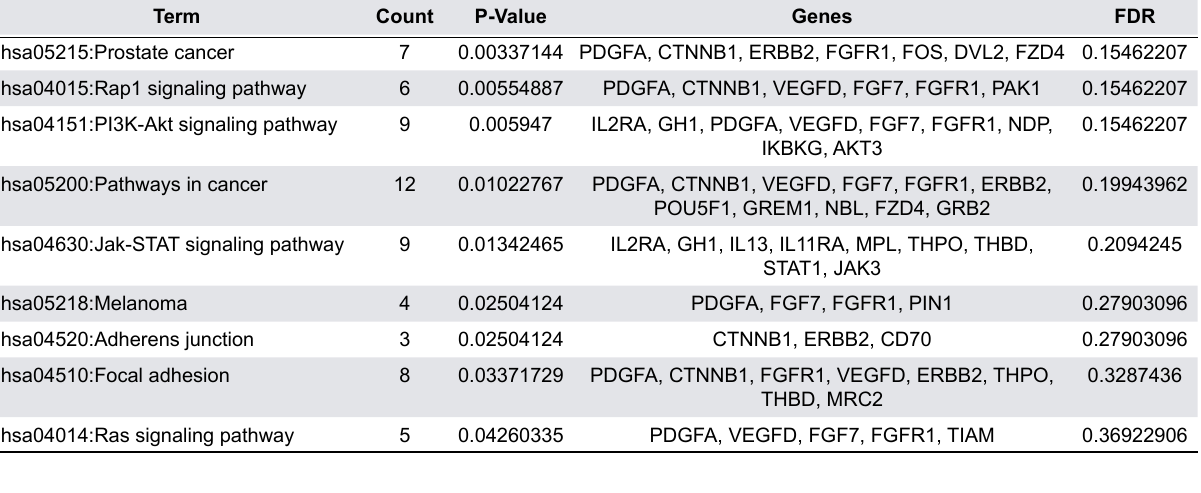
Table 2- KEGG pathway analysis of differential expressed genes associated with ameloblastoma